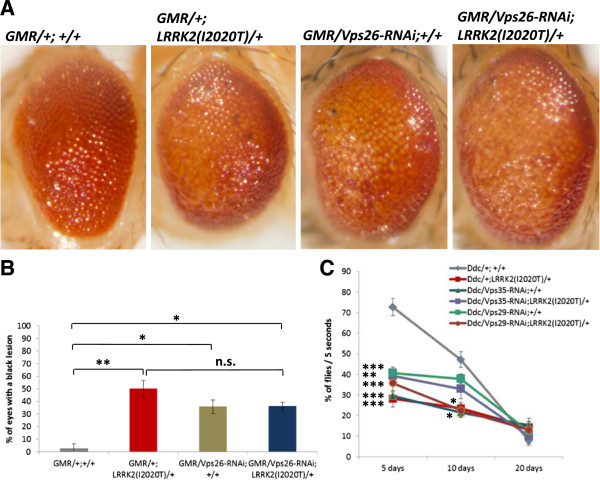
Knocking down components of the cargo-recognition subunit of the retromer complex causes an eye phenotype and a locomotor impairment. The phenotypes are not additive with LRRK2(I2020T) phenotypes. A) Representative stereomicroscope images and B) Quantification of black lesions in the eyes Vps26 knock-down flies. Total of 444 eyes from 3-9 independent crosses/genotype (males and females) was analyzed. Statistically significant difference compared to control (GMR alone) is denoted as * for P < 0.05 and ** for P < 0.001. Data were statistically analyzed by One-Way ANOVA, Bonferroni’s post-test. C) Effect of Vps35 or Vps29 knock-down on locomotor activity. N = 3-13 cohorts of ten. Statistical analysis: Two-Way ANOVA, Tukey’s post-test. Statistically significant difference compared to control (Ddc alone) is denoted as * for P < 0.05, ** for P < 0.001, or *** for P < 0.0001. All flies were reared at 29°C.